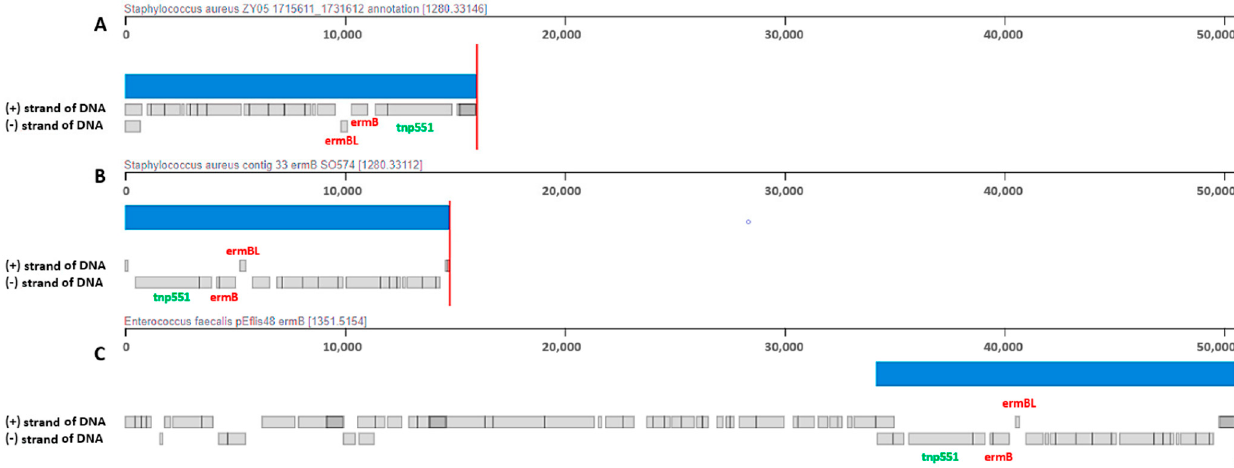
Figure 3. Small-scale local comparison of three erm B encoding structures and its genetic organization: ( A )— erm B carrying LCB from CA-MRSA ZY05; ( B )— erm B carrying contig 33 from CA-MRSA SO574/12; and ( C )— erm B encoded region from E. faecalis plasmid pEflis48. Strips in the same blue color inform that aligned structures display each other as homologues and occur with a high level of similarity, coverage, and structure organization.